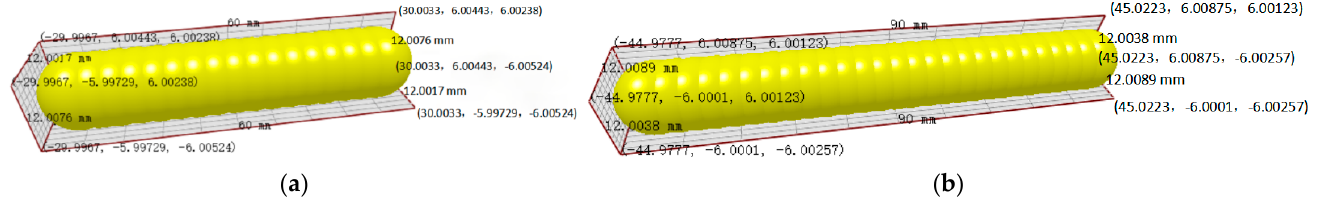
Figure 5. Particle models of green manure stalks. ( a ) 60mm stem model. ( b ) 90mm stem model.